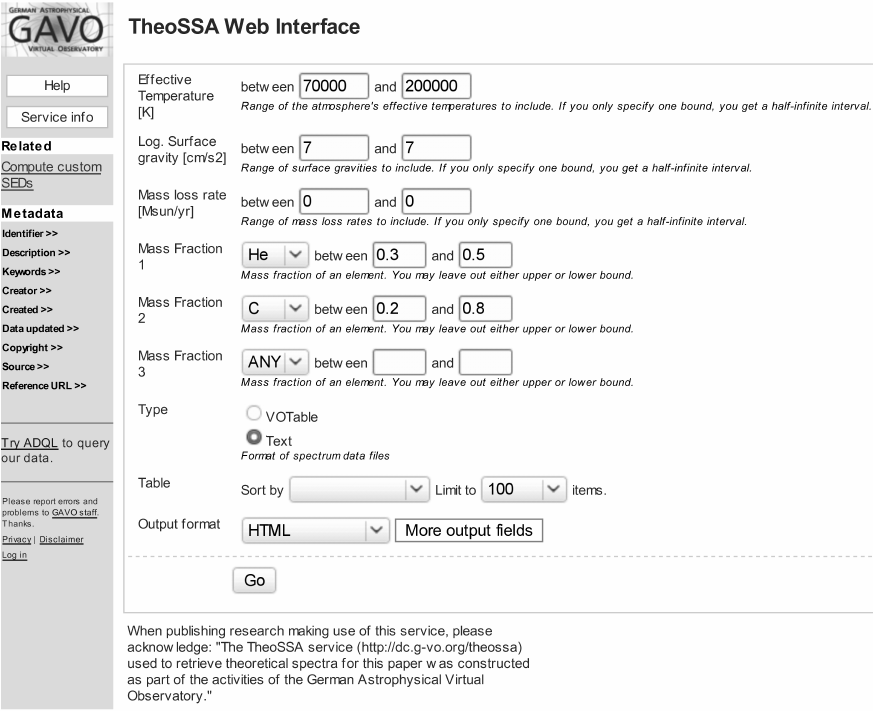
Fig. 1. Web interface of